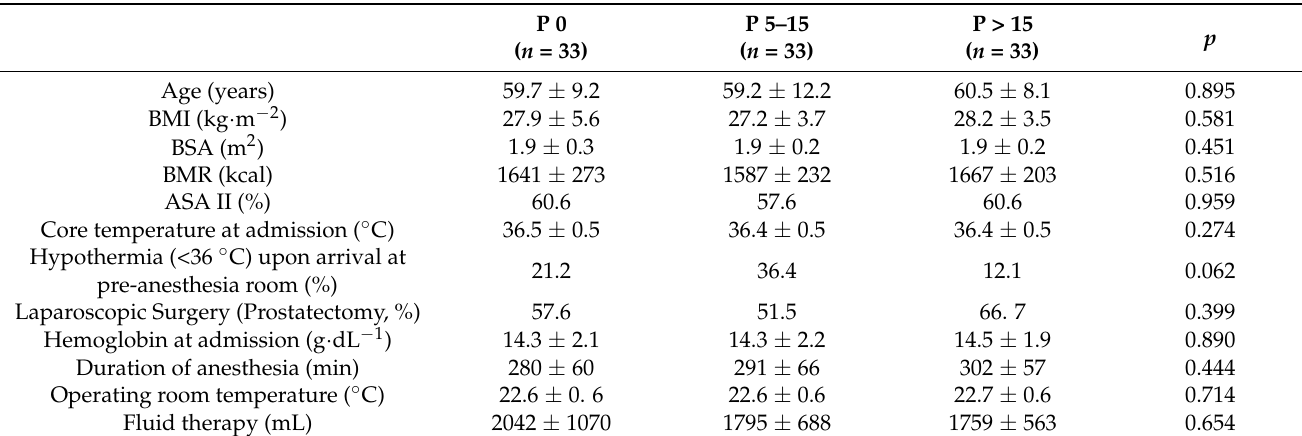
Table 1. Patient characteristics and perioperative variables.